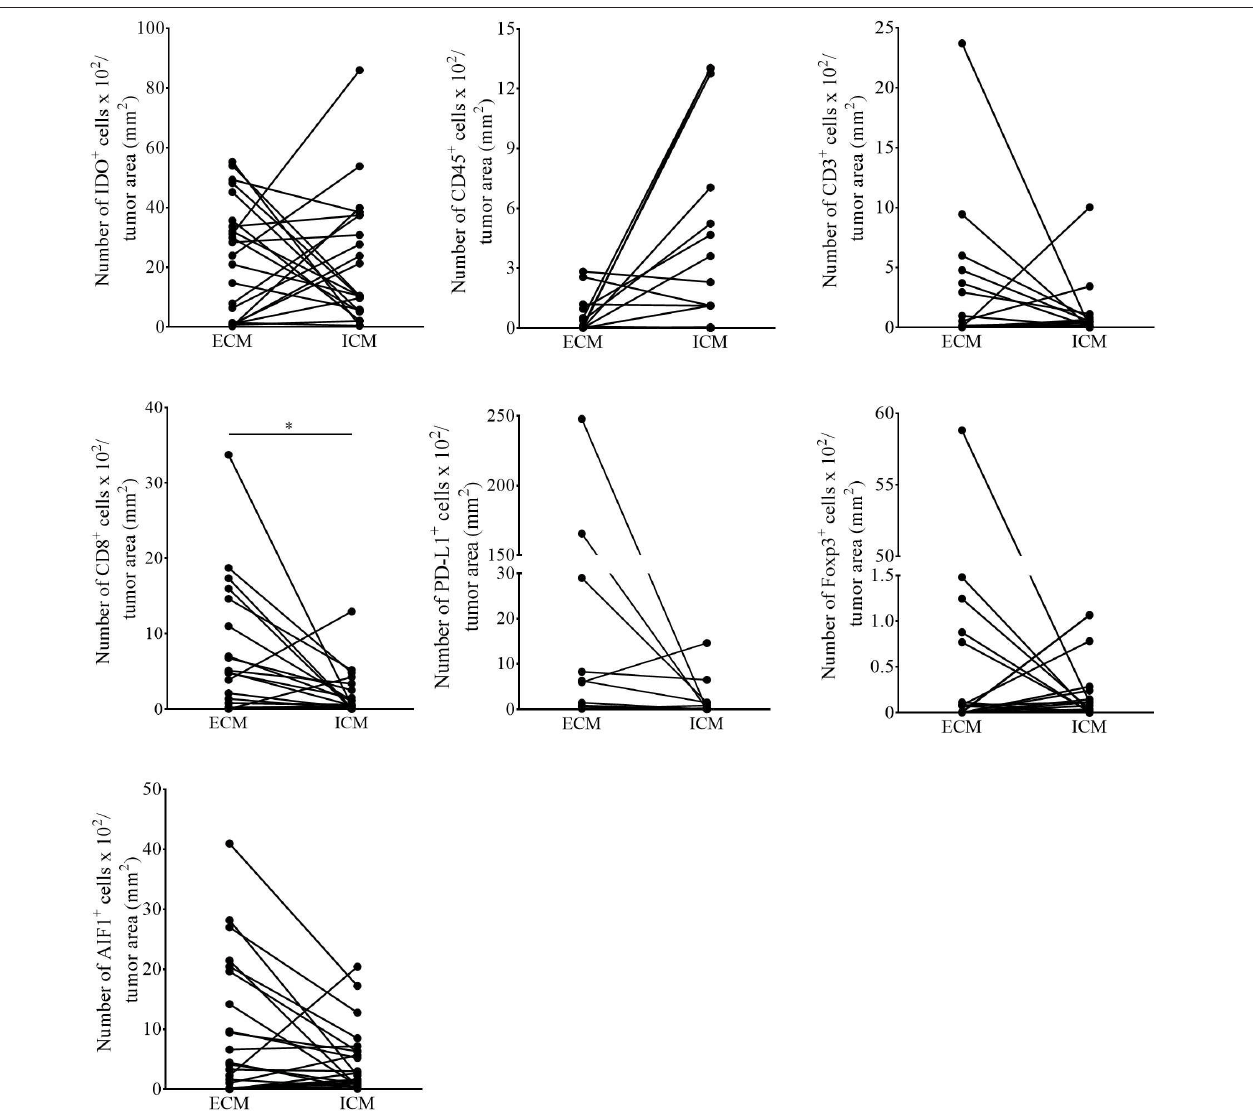
FIGURE 3 | Quantitative assessment for the number of immunoreactive cells in patient-matched melanoma metastases. The number of IDO, CD45, CD3, CD8, FoxP3, PD-L1, and AIF1 positive cells in intra- (ICM) and corresponding extracranial (ECM) metastases of individual melanoma patients ( n = 19 patients, n ECM = 22, n ICM = 19; * p <